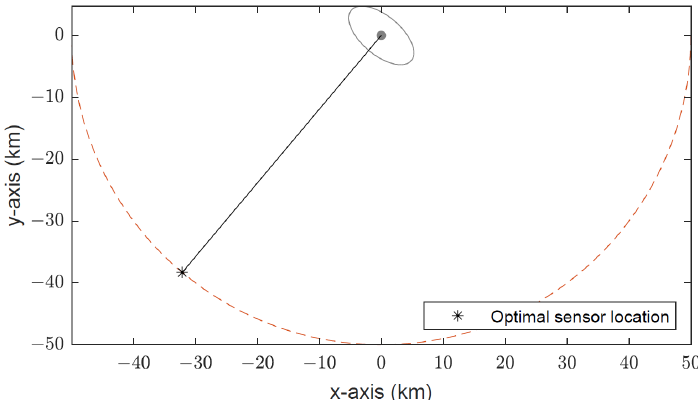
Figure 8. Optimal target–sensor geometry, where the target–sensor range vector is perfectly aligned with the minor axis of the error ellipse of the Gaussian prior